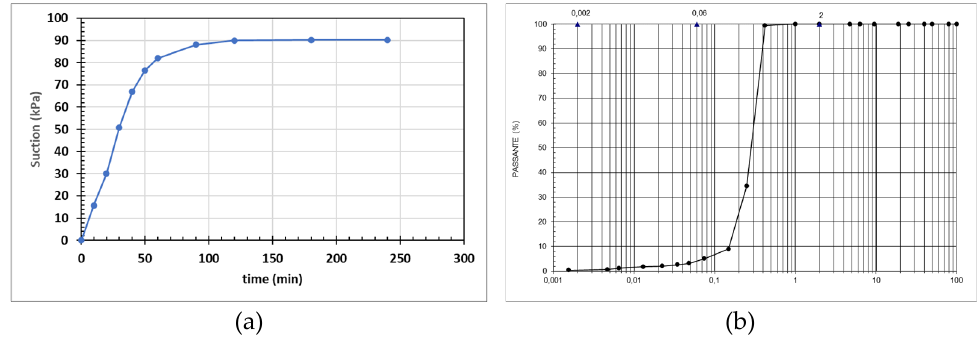
Figure 13. Example of suction measurement with 2100 F remote tensiometers on an unsaturated specimen of a sand: ( a ) mini-tensiometer measurement versus elapsed time during matric suction equalization; ( b ) grain size distribution.